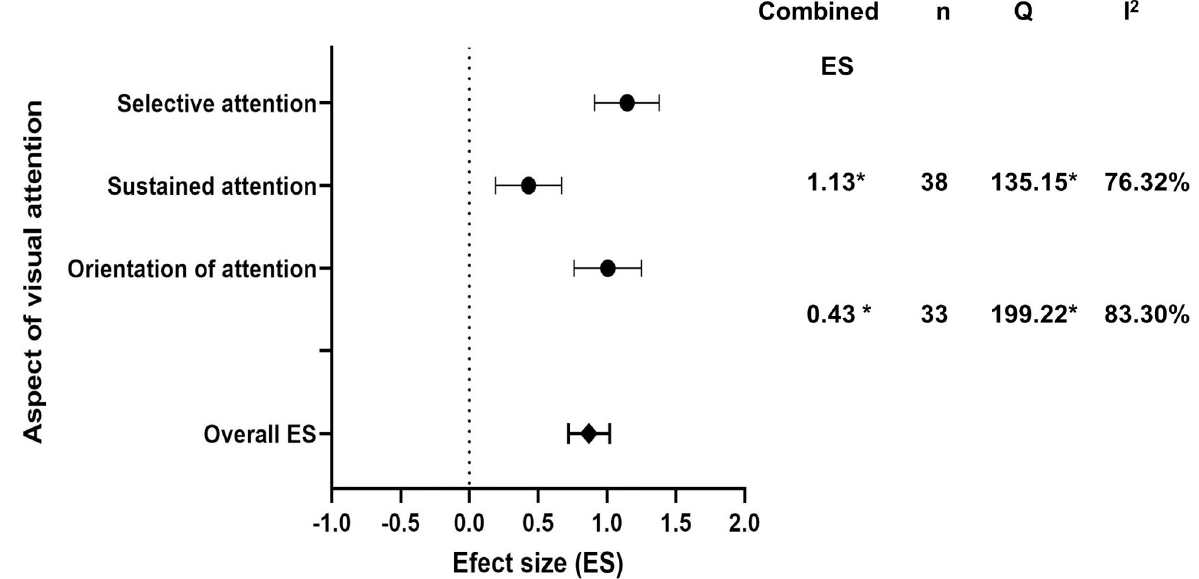
Fig 3. Forest plot showing overall and combined effect size. Forest plot of combined ES, 95% CI, number visual attention tasks (n), heterogeneity (Q) and the magnitude of heterogeneity (I2) of overall, selective visual attention, sustained visual attention, and the orientation of visual attention. Note: � p <